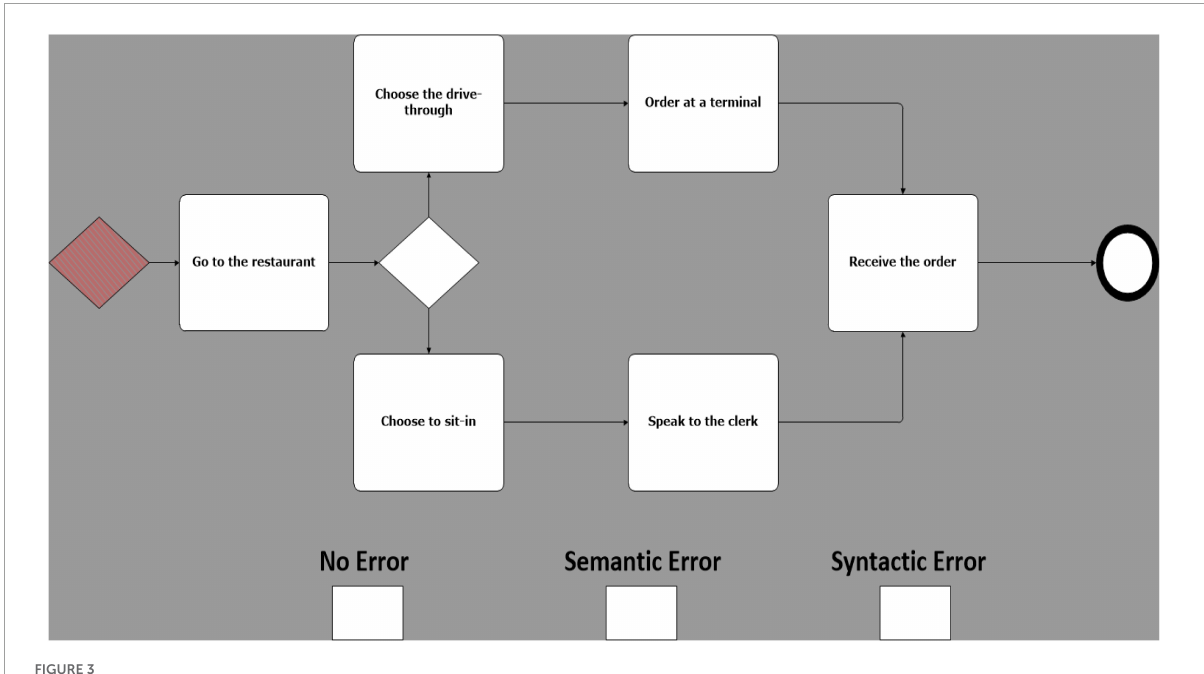
FIGURE3 Example of a model with syntactic error (use of invalid